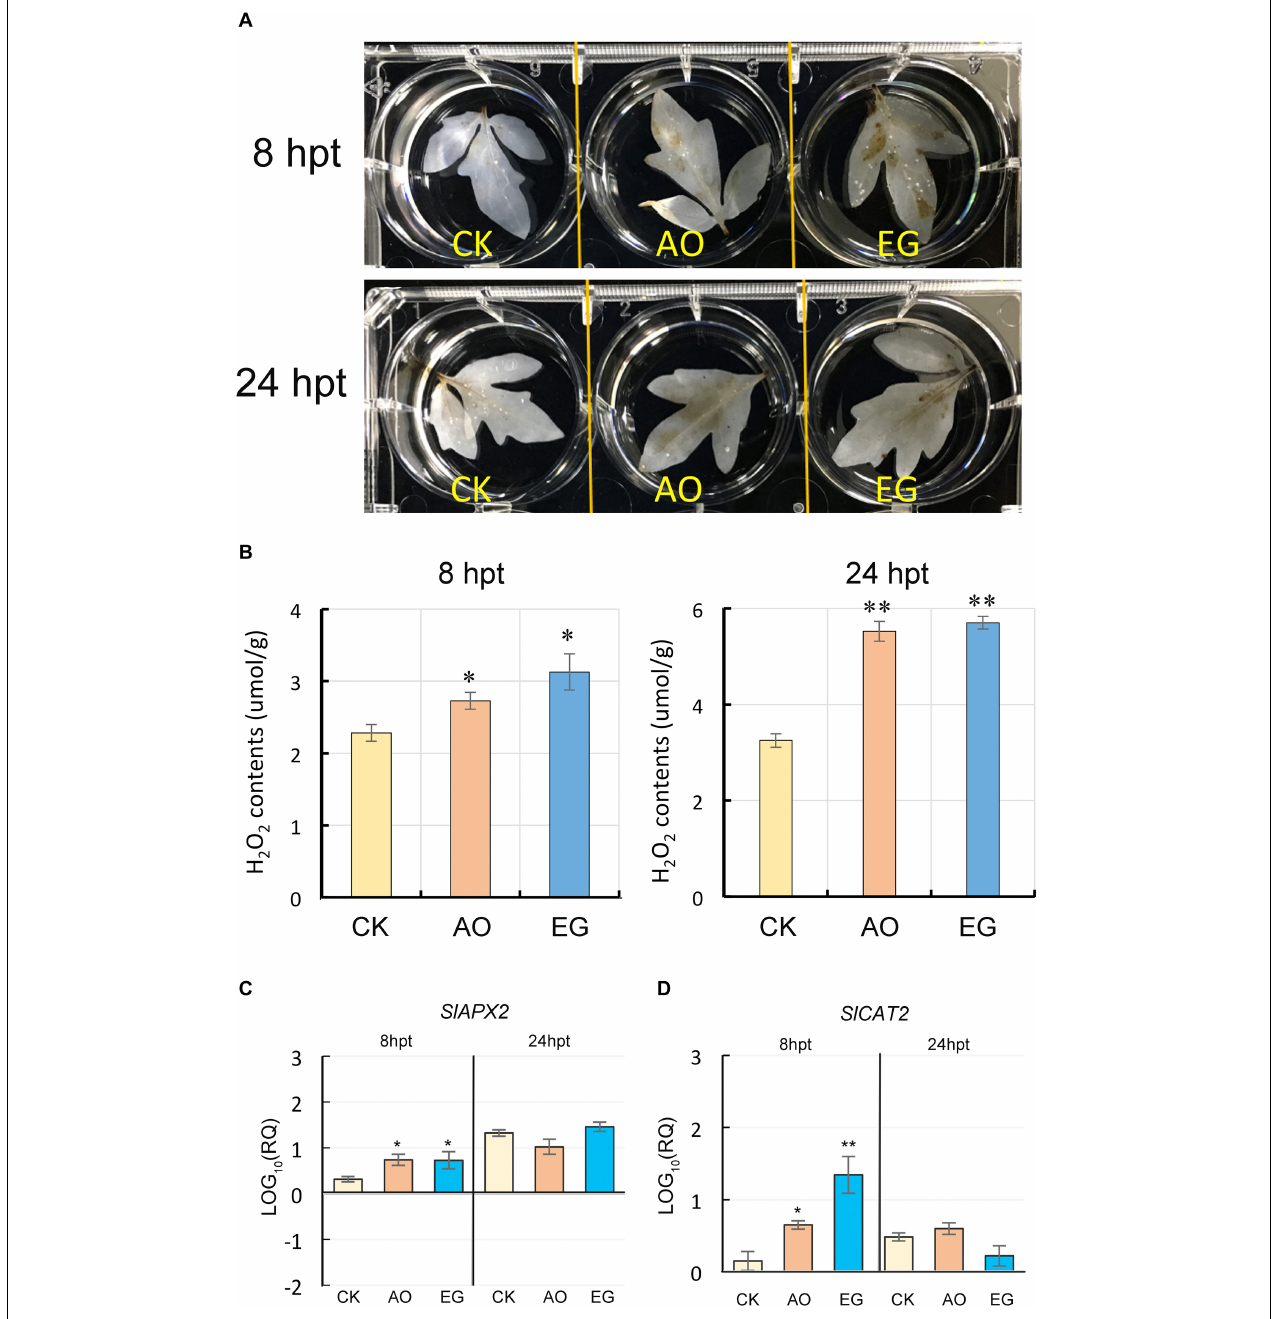
FIGURE 8 | Effects of anise oil and eugenol on the accumulation of H 2 O 2 and the expression of antioxidant genes in tomato plants. 3 (cid:48) -Diaminobenzidine (DAB) staining was used to detect H 2 O 2 in control, anise oil-, and eugenol-treated tomato plants at 8 hpt and 24 hpt (A) . Furthermore, H 2 O 2 content was quantified by titanium chloride method (B) . In addition, expression of antioxidant genes, SlAPX2 (C) and SlCAT2 (D) , was also analyzed by RT-qPCR. The β -actin expression level was used as the internal control. Relative gene expression levels were normalized against the expression level in untreated tomato plants. Data were analyzed with the 2 − (cid:49)(cid:49) Ct method. Bars represent the mean ( ± standard error of the mean) of three independent biological replicates each with three technical replicates. Significant differences between control and anise oil- or eugenol-treated plants were assessed with Student’s t -test ( ∗ P < 0.05; ∗∗ P <